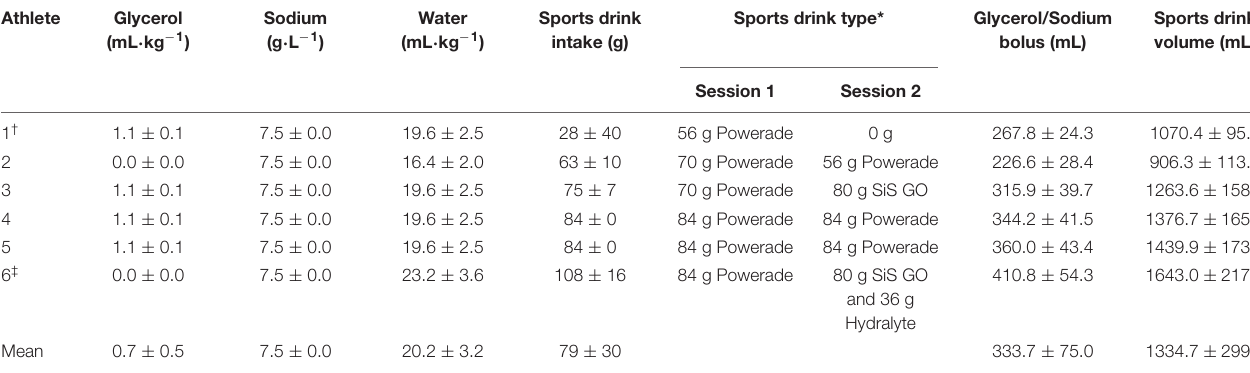
TABLE 5 | Hyperhydration protocol used prior to key training sessions (16th July and 23rd July 2021) during the team holding camp. Athlete Glycerol